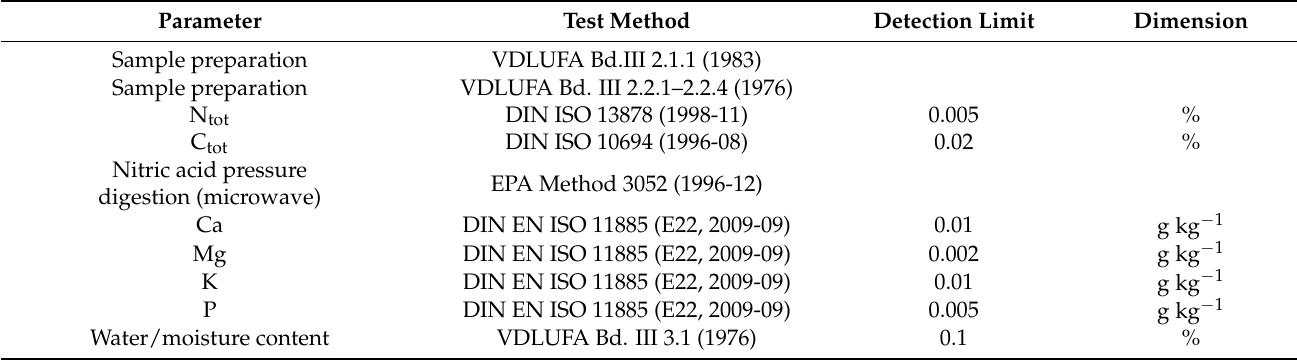
Table 3. Determination methods used for leaf sample